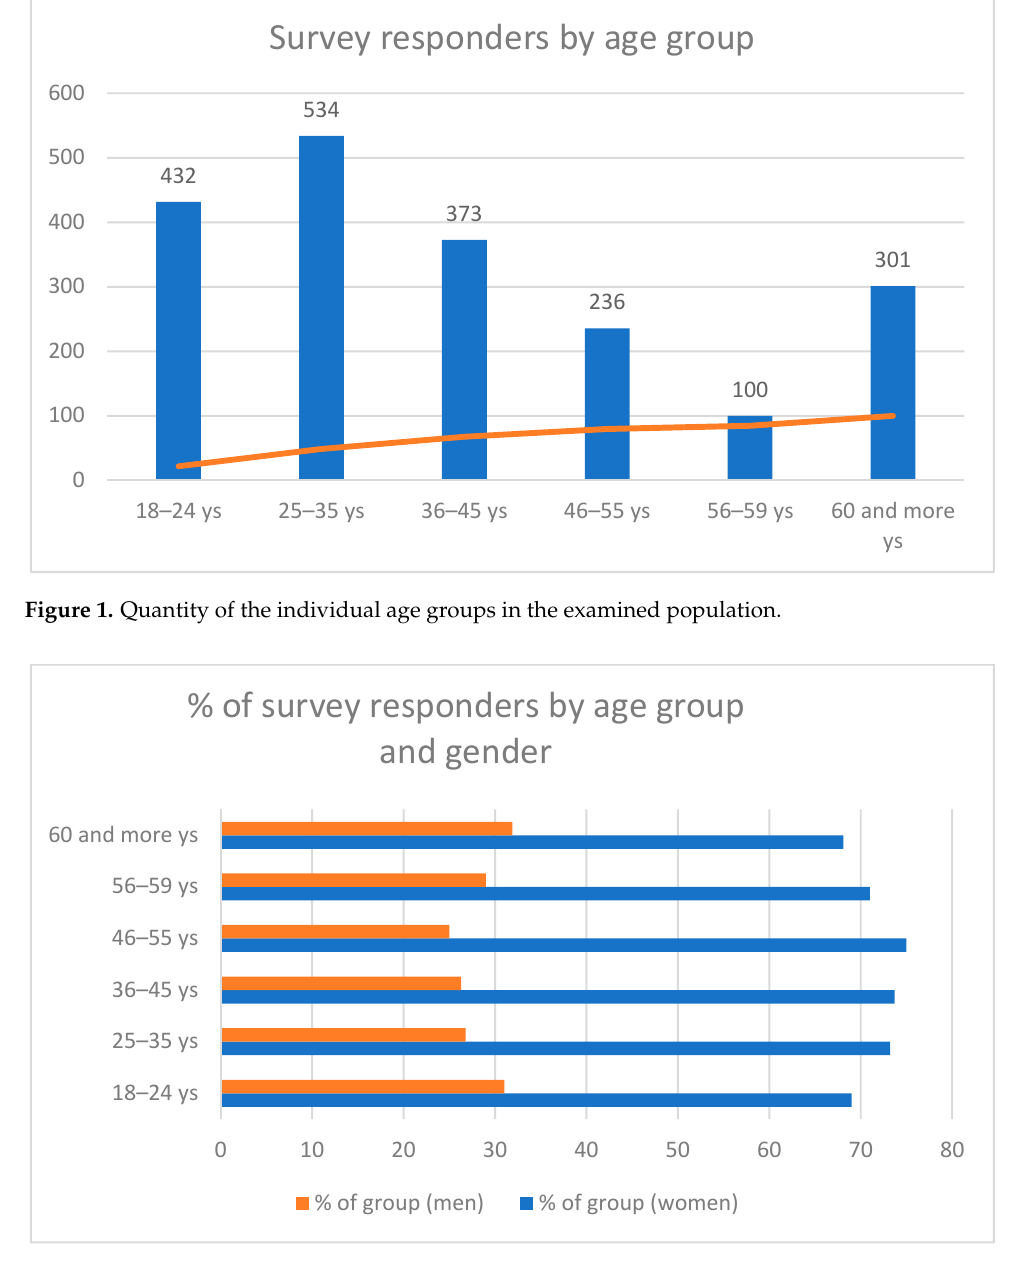
Figure 2. Survey respondents by age and gender.